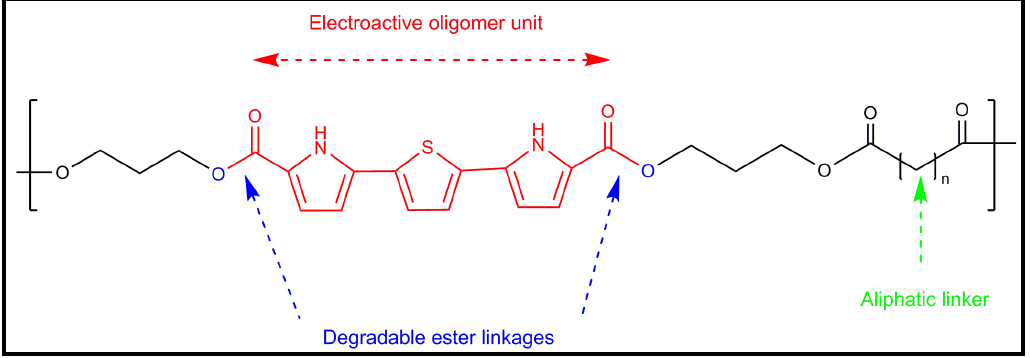
Figure 17. Scheme illustrating the key components of a novel biodegradable conducting polymer: conducting pyrrole-thiophene-pyrrole oligomer, degradable ester linkages and aliphatic